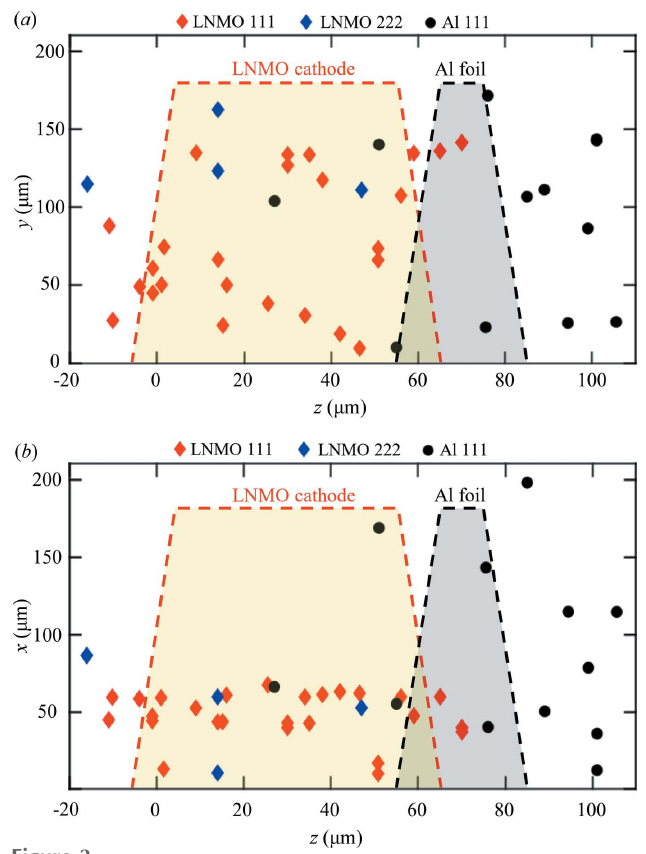
Figure 3 Measured 3D positions of particles in a 60 m m-thick battery cathode. The cathode consisted of the LNMO material (yellow area), deposited on 20 m m-thick Al foil (gray area). Slopes of the red and black dashed contours illustrate the thickness uncertainties for the LNMO and Al layers, respectively, which are estimated to be about 10 m m on each side. LNMO (111) (red markers) and LNMO (222) (blue markers) reflections were used. For Al, we used the (111) reflection (shown by black markers). ( a ) yz projection. ( b ) xz